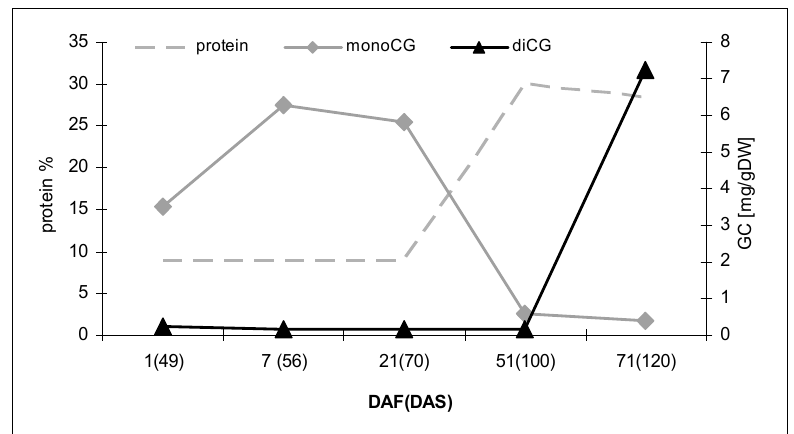
Figure 4. Schematic representation of changes in total protein content (% of DW) and cyanogenic mono- and diglucoside levels during generative development of flax (control) plant. DAF, days after flowering; DAS, days after sowing.